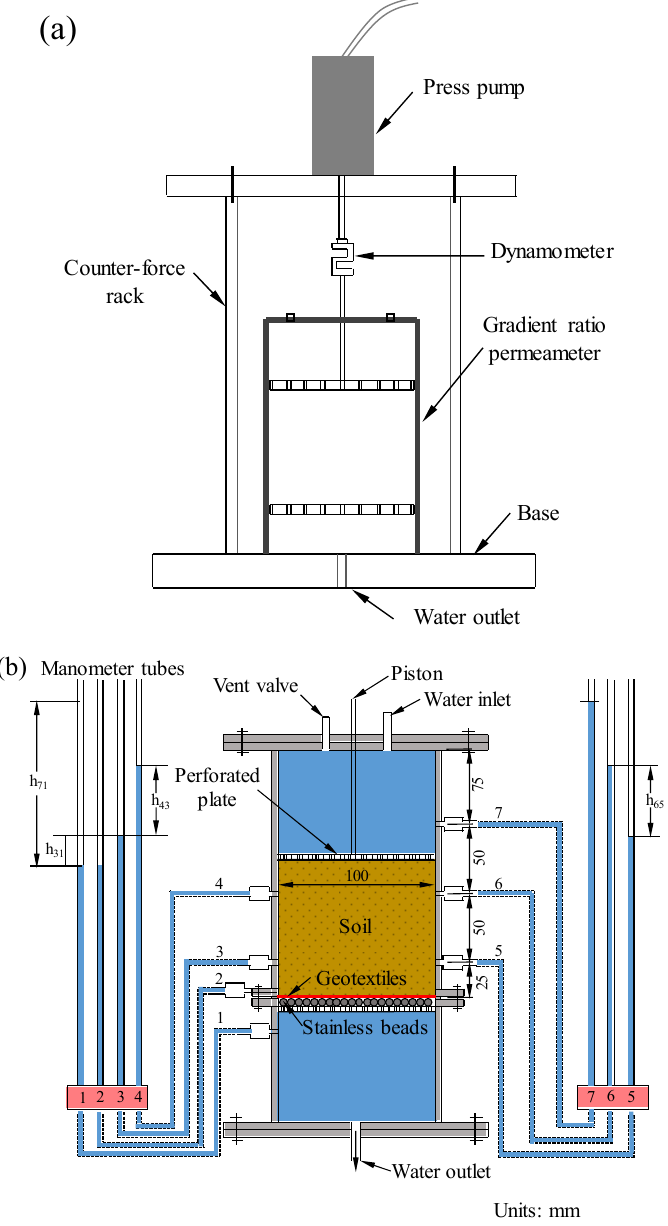
Figure 3. Schematic of a new gradient ratio device for applying normal stress: ( a ) diagram of normal stress application; ( b ) details of gradient ratio permeameter .